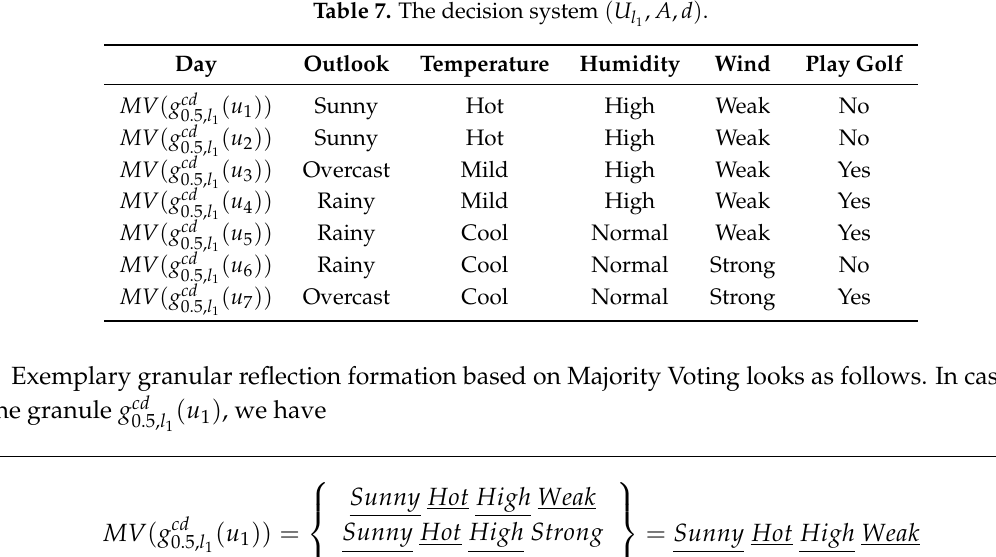
Table 7. The decision system ( U l